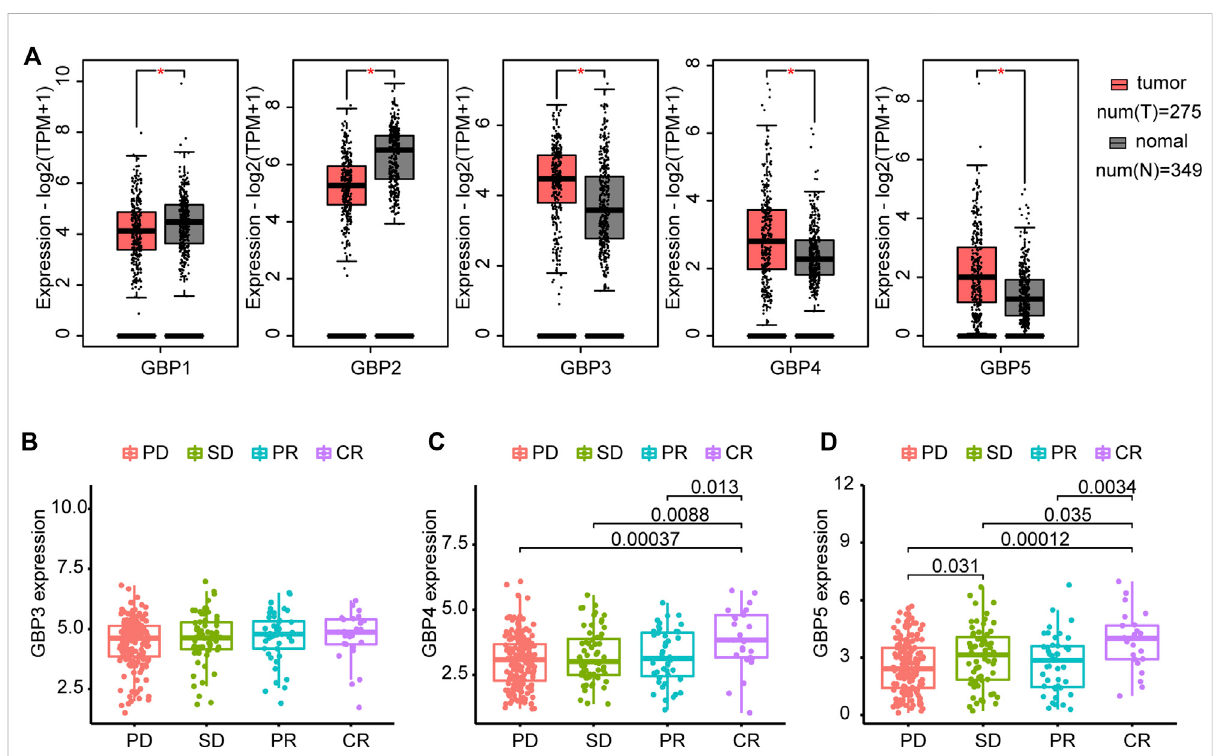
FIGURE 2 Differential expression of GBPs and prediction of ICB (immune checkpoint blockade) response (A) GBPs expression difference between tumor and normal tissues in COAD (Colon adenocarcinoma) by GEPIA2. The expressions of GBP1 and GBP2 in normal tissues are signi fi cantly higher than those in tumor tissues. The expressions of GBP3, GBP4, and GBP5 in tumor tissues are signi fi cantly higher than those in normal tissues. “ * ” indicates p < 0.05 (B) Differences of GBP3 expression between groups with different responses to immunotherapy in the IMvigor210 cohort. GBP3 expression is 4.451806 ± 1.031910 in PD group, 4.613511 ± 1.052200 in SD group, 4.669342 ± 1.065907 in PR group and 4.679646 ± 1.037475 in CR group. (C) Differences of GBP4 expression between groups with different responses to immunotherapy in the IMvigor210 cohort. GBP4 expression is 3.039644 ± 0.9899737 in PD group, 3.232032 ± 1.0081706 in SD group, 3.205698 ± 1.0478816 in PR group and 3.886223 ± 1.1831482 in CR group. (D) Differences of GBP5 expression between groups with different responses to immunotherapy in the IMvigor210